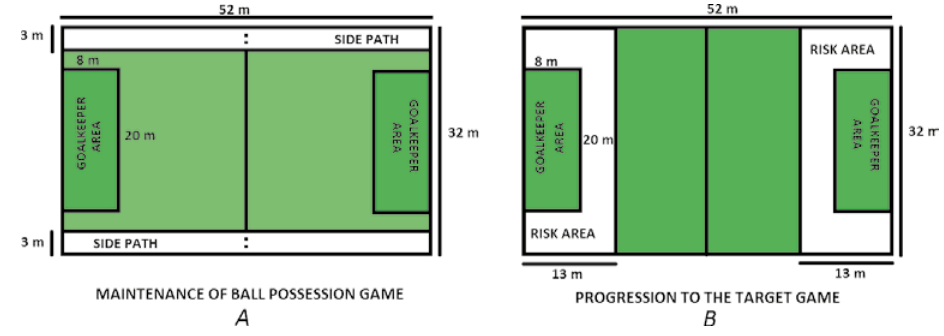
Figure 1. Field dimensions used at the different